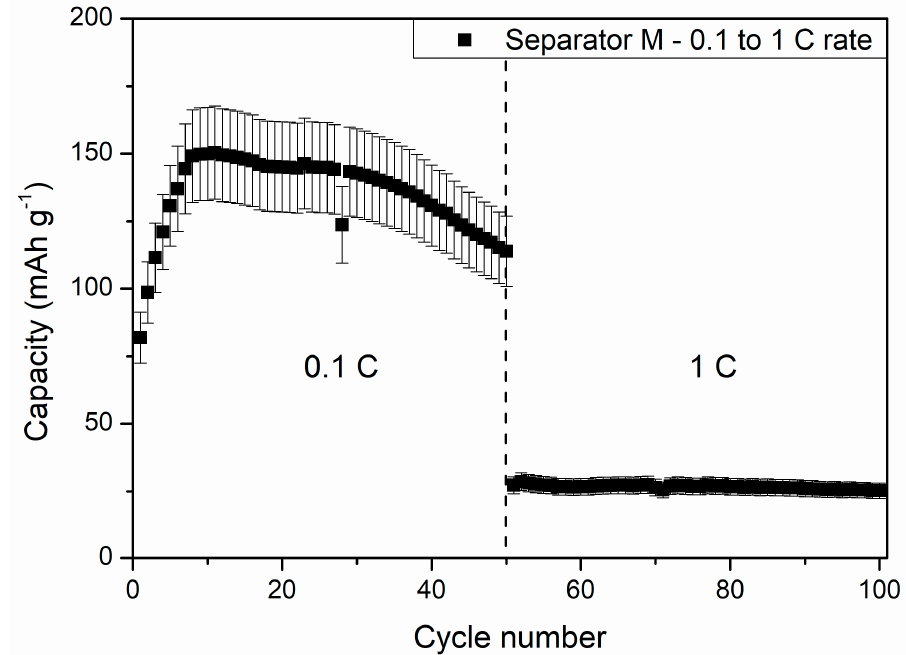
Figure 16. The effect of further cycling of the cell with composite film M applied as a conductive separator at 5 °C and 1 C current rate—exceptionally stable work of the battery can be noted.